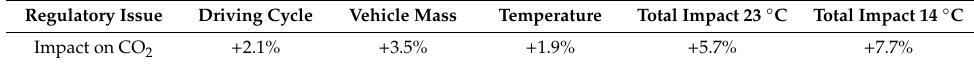
Table 2. Total estimated impact of switching from NEDC to WLTP